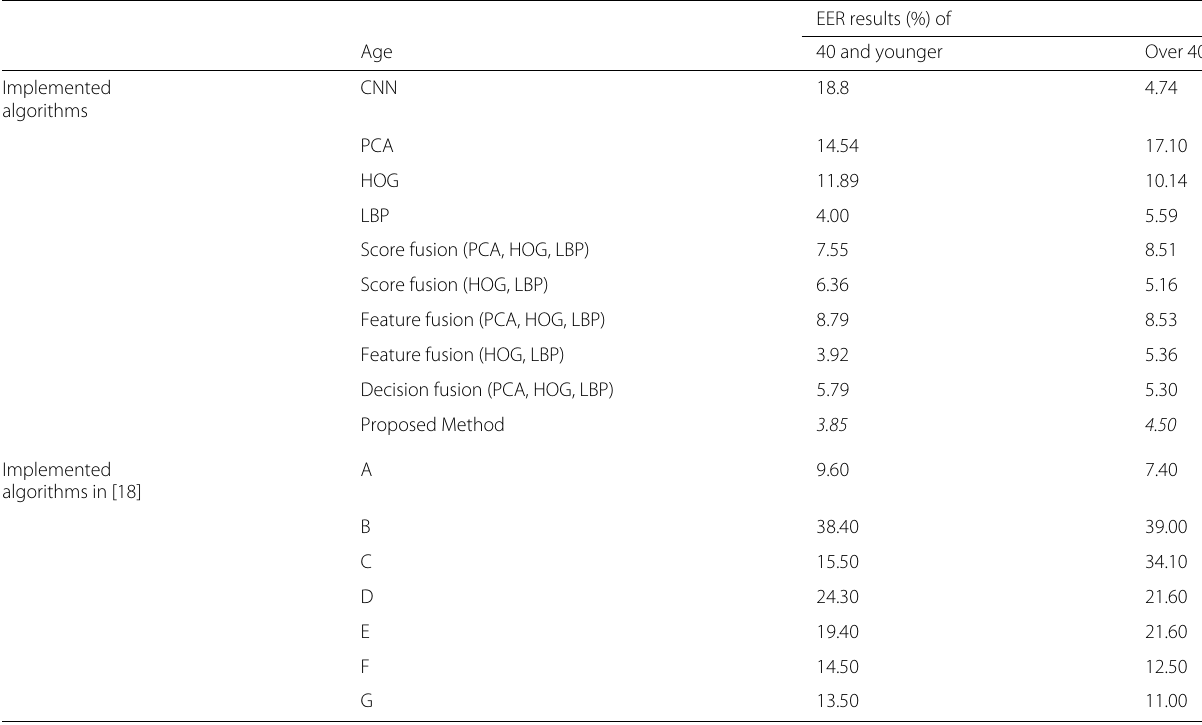
Table 8 EER results of age-based experiments for identical twins